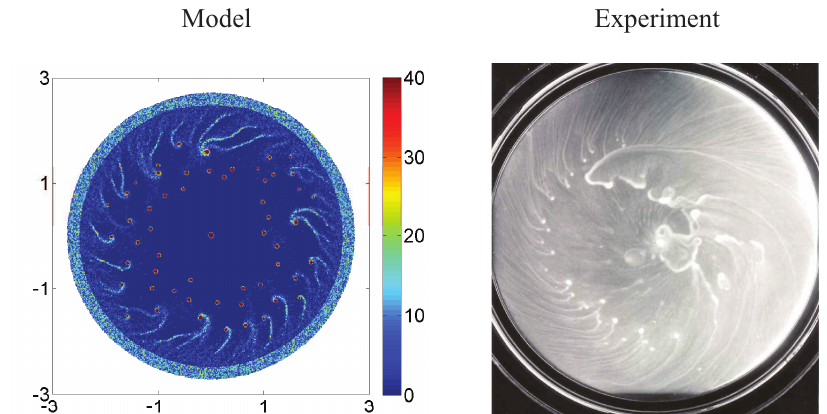
Figure 9. Spiral streams in a growing Proteus mirabilis colony. Reproduced from [170] with permission.